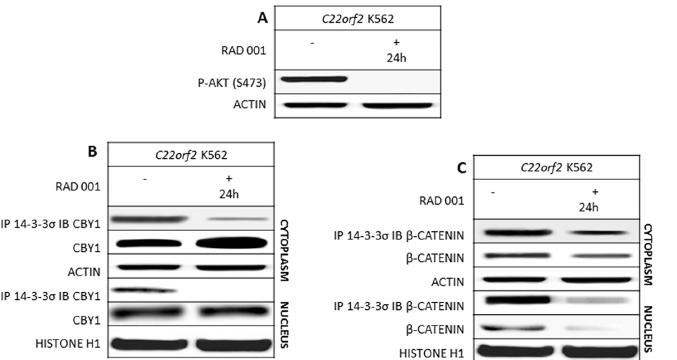
and C- β catenin expression and interaction with 14-3-3 σ were assayed in the cytoplasmic and nuclear compartments of C22orf2 K562 cells at 24 th hour of exposure to RAD001. The absence of off-target effects was assayed (Supplementary section, S2 Fig). See legend to Fig 1 for technical details.